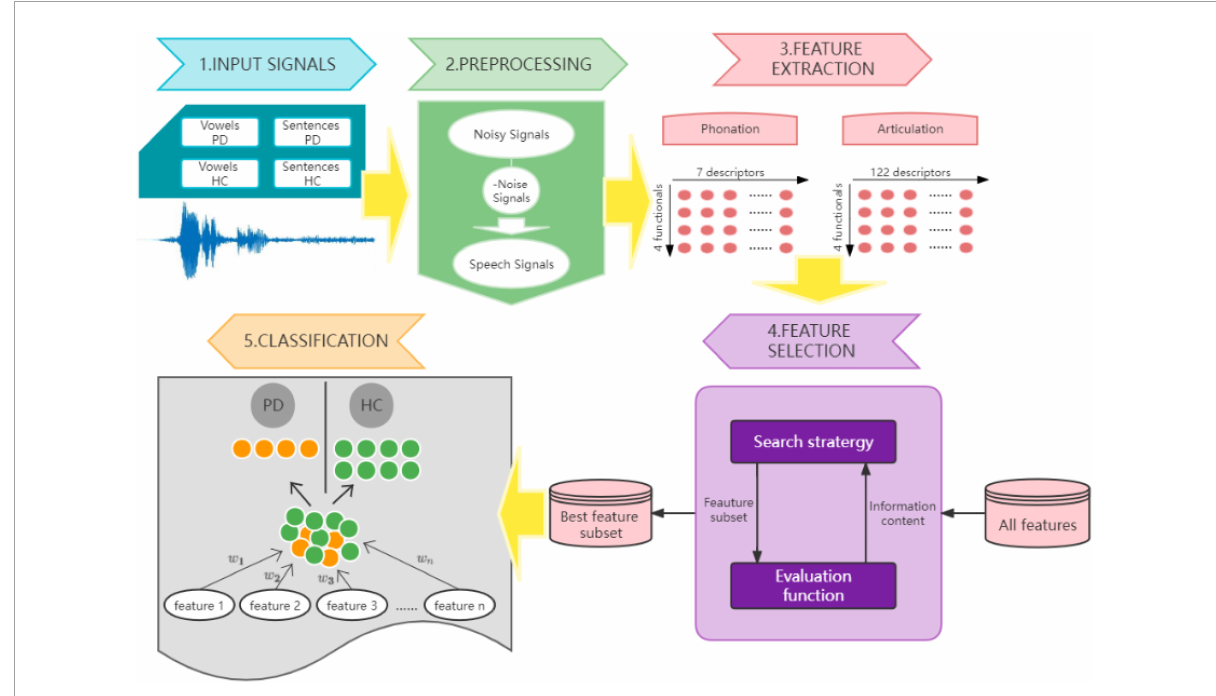
FIGURE1 Automatic Parkinson’s disease detection